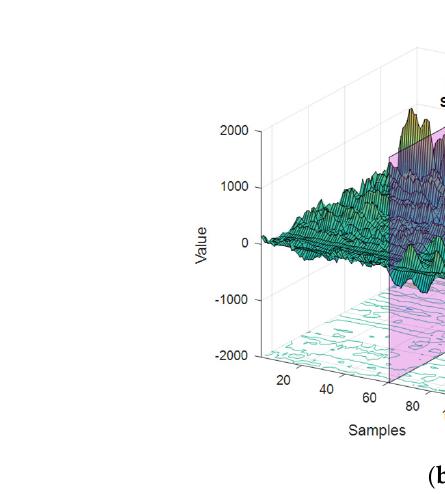
Figure 4. Determining the appropriate number of features in the SVD algorithm .